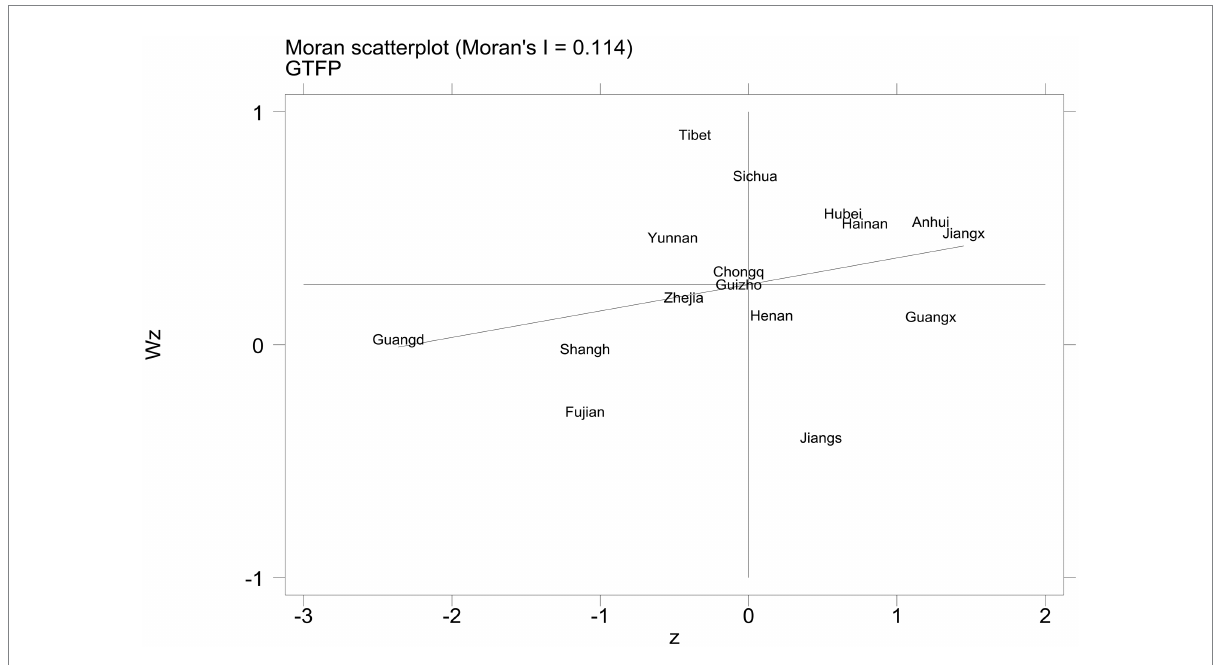
FIGURE 5 Distribution of Moran index in southern